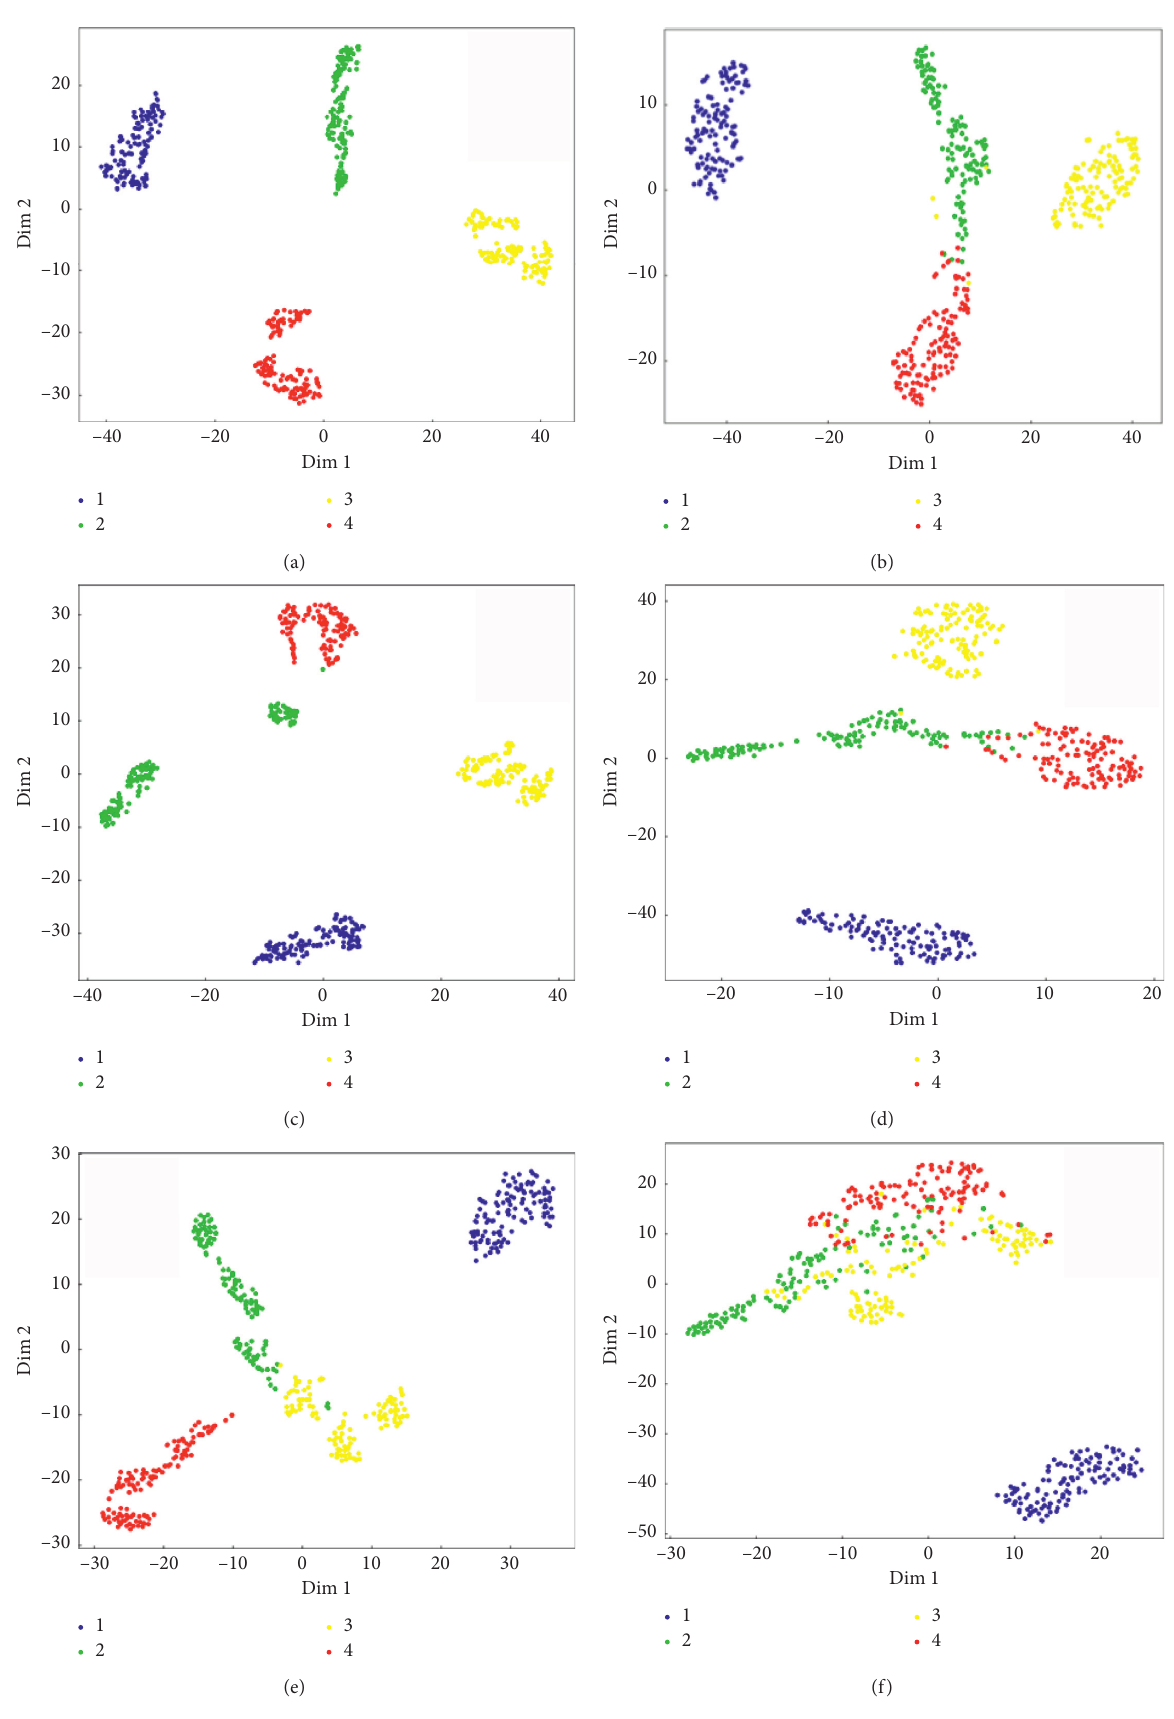
Figure 6: Visualization of the learned features using different methods: (a) TDRN; (b) TDCNN; (c) DRN-S; (d) DCNN-S; (e) DRN-T; (f)